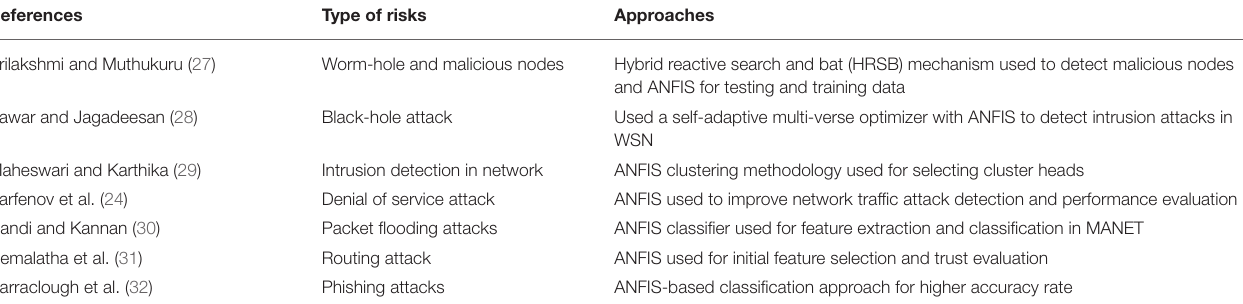
TABLE 1 | Recent research on ANFIS and network security issues.